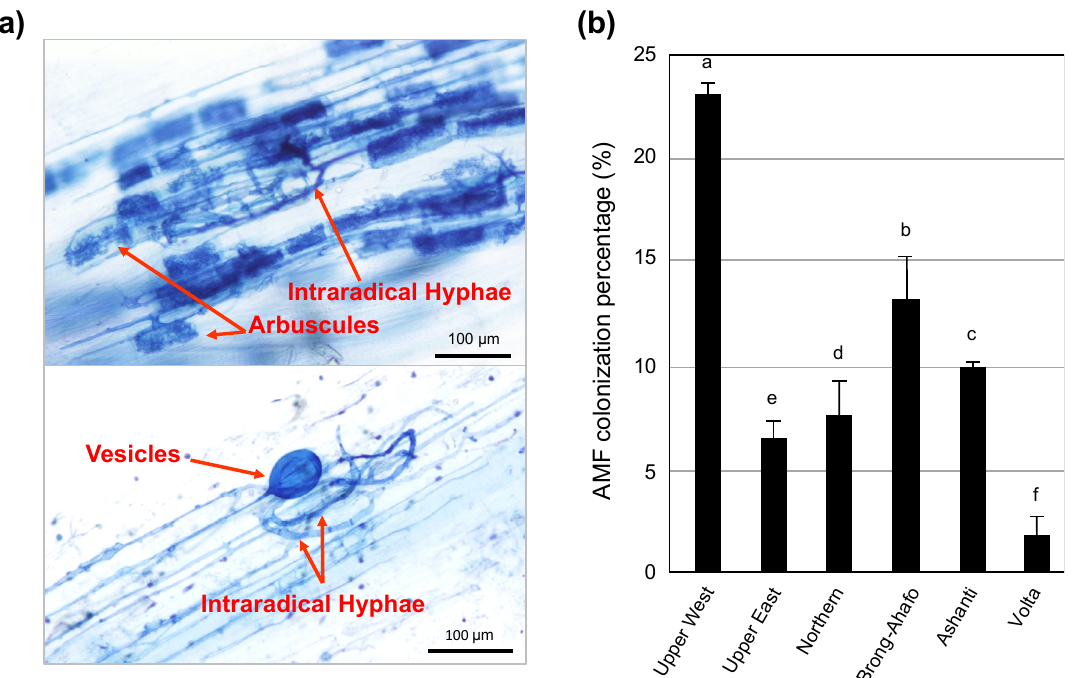
Figure 2. Arbuscular mycorrhizal fungi (AMF) colonization with rain-fed cultivated rice plants in Ghana: ( a ) Photomicrographs of structural colonization of AMF in rice roots stained with trypan blue solution. The observed morphological structures of AMF were hyphae, arbuscules, and vesicles. ( b ) The rate of AMF colonization in rice roots (based on the presence of hyphae, arbuscules, and vesicles) evaluated throughout the six di ff erent regions (Upper West, Upper East, Northern, Ashanti, Brong-Ahafo, and Volta) where rice roots were sampled from. Di ff erent letters (a, b, c, d, e, f) indicate significant di ff erences between locations based on Tukey’s test ( p < 0.05). Sampling sites in rice-cultivated fields of Ghana with the study area colored in three di ff erent colors: (a) The map shows 57 sampling areas marked with black triangles among six di ff erent regions under three agroecological zones of Ghana. (b) Pictures of rice fields in Ghana where samples were collected.